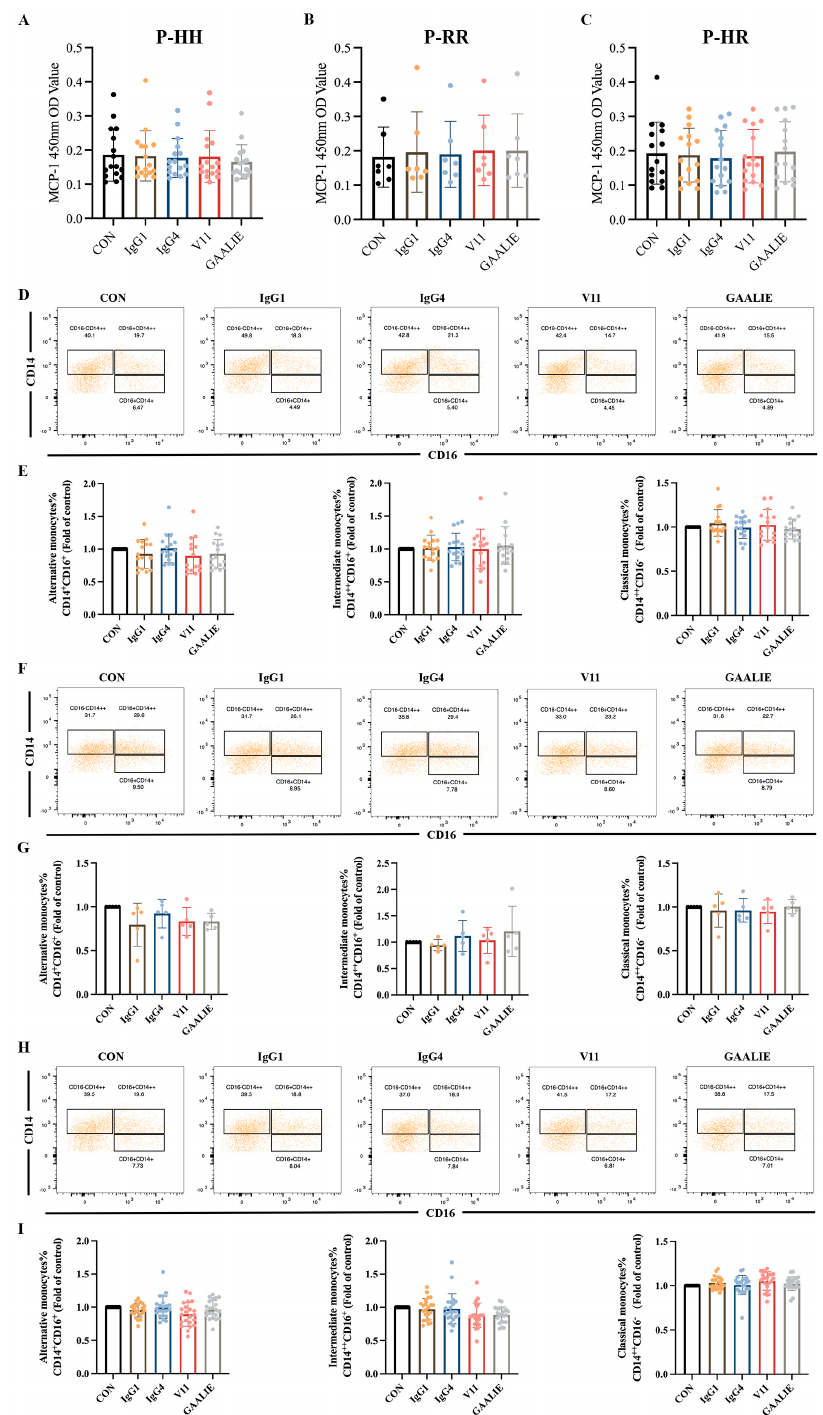
Figure 7. Effects of different isoforms of antibodies and mutants on PBMCs of patients. ( A ) Release of MCP-1 in Fc γ RIIA-131H/H patients ( n = 16). ( B ) Release of MCP-1 in Fc γ RIIA-131R/R patients ( n = 7). ( C ) Release of MCP-1 in Fc γ RIIA-131H/R patients ( n = 15). ( D , E ) Flow cytometry analysis of monocyte differentiation in Fc γ RIIA-131H/H patients ( n = 15). ( F , G ) Flow cytometry analysis of monocyte differentiation in Fc γ RIIA-131R/R patients ( n = 5). ( H , I ) Flow cytometry analysis of monocyte differentiation in Fc γ RIIA-131H/R patients ( n = 22). Data are expressed as mean ± SD. One-way ANOVA followed by Tukey’s multiple comparisons